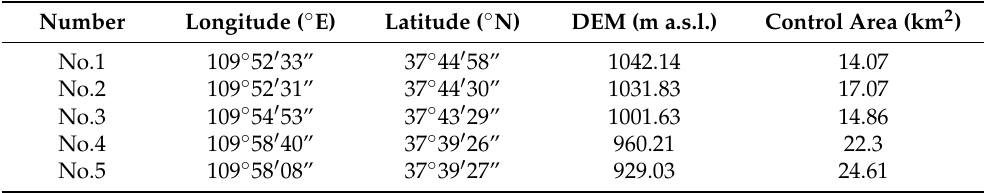
Table 1. General information of the five large-scale silt dams with storage capacity > (0.5)10 6 m 3 in the